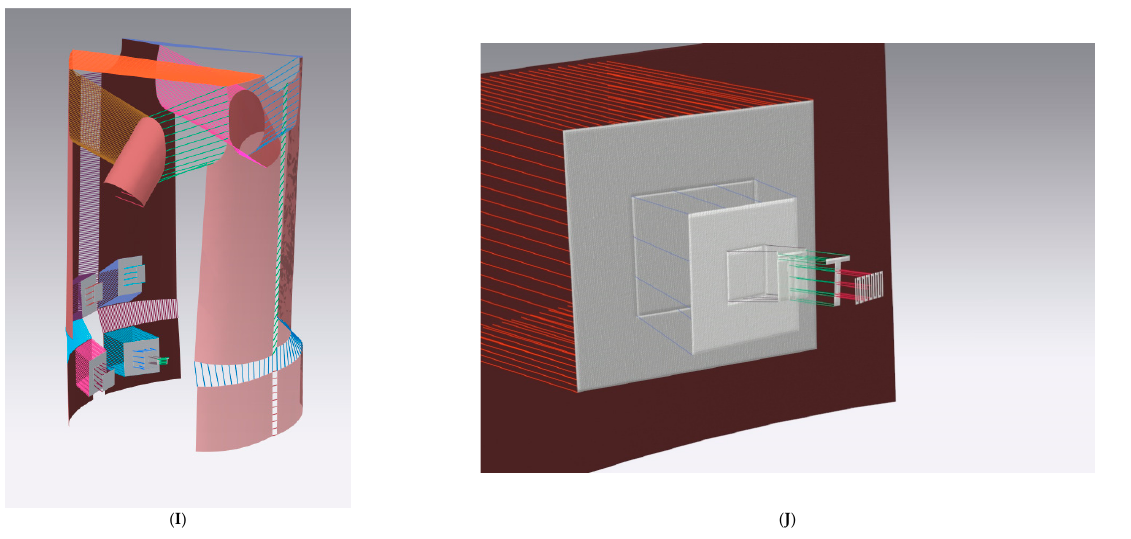
Figure 6. The patch antenna shown in Figure 3 [8] integrated in the lower part of the proposed short-sleeved A-line dress. Subfigure content is explained in the text.